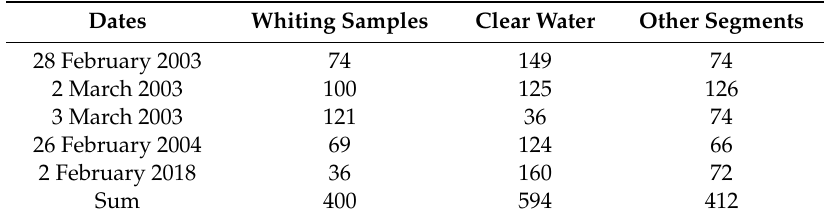
Table 2. Dates and number of image object samples selected from various